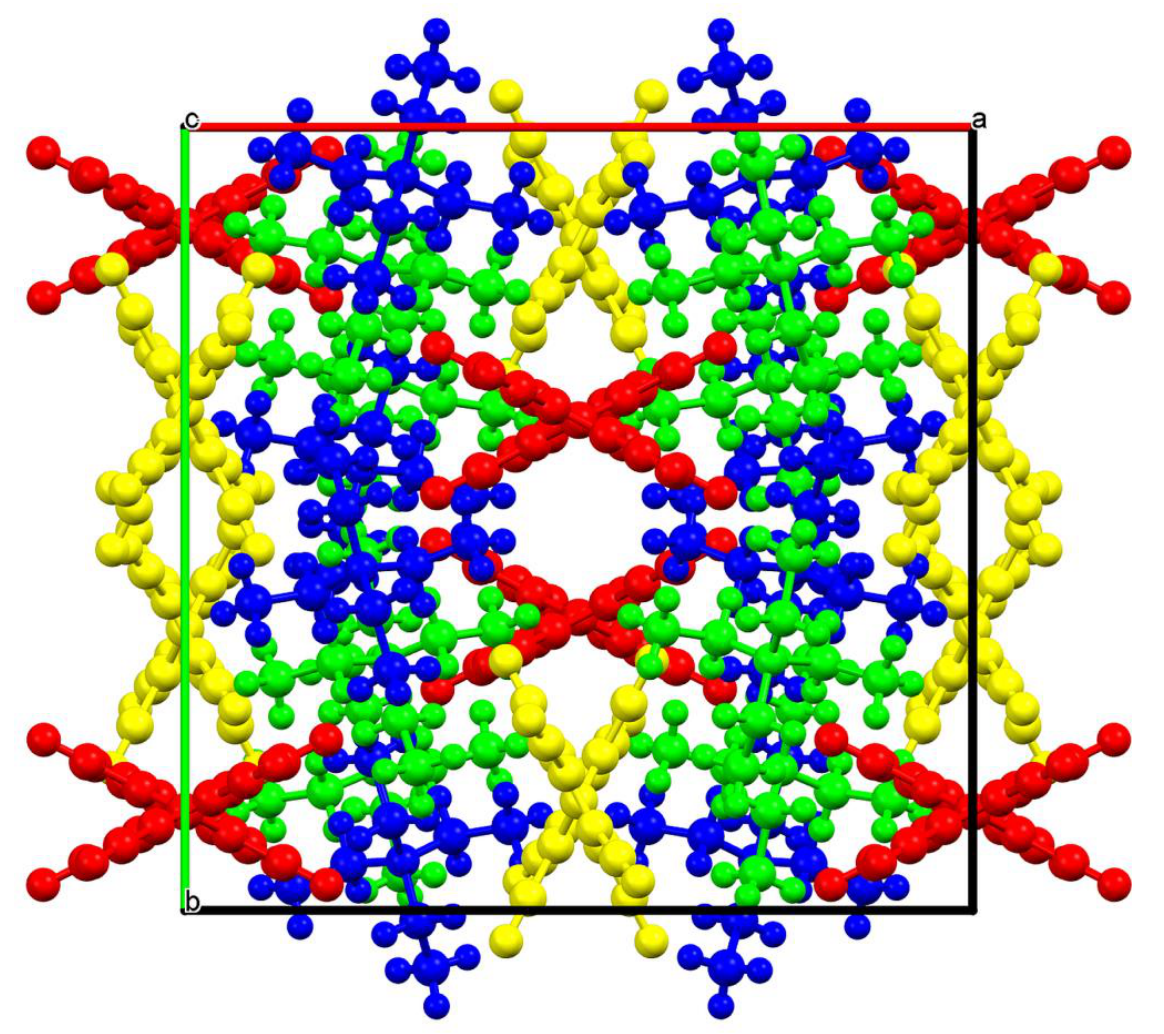
Figure 11. Packing plot ( MERCURY ) of compound 5 , watched along the crystallographic c axis. Color